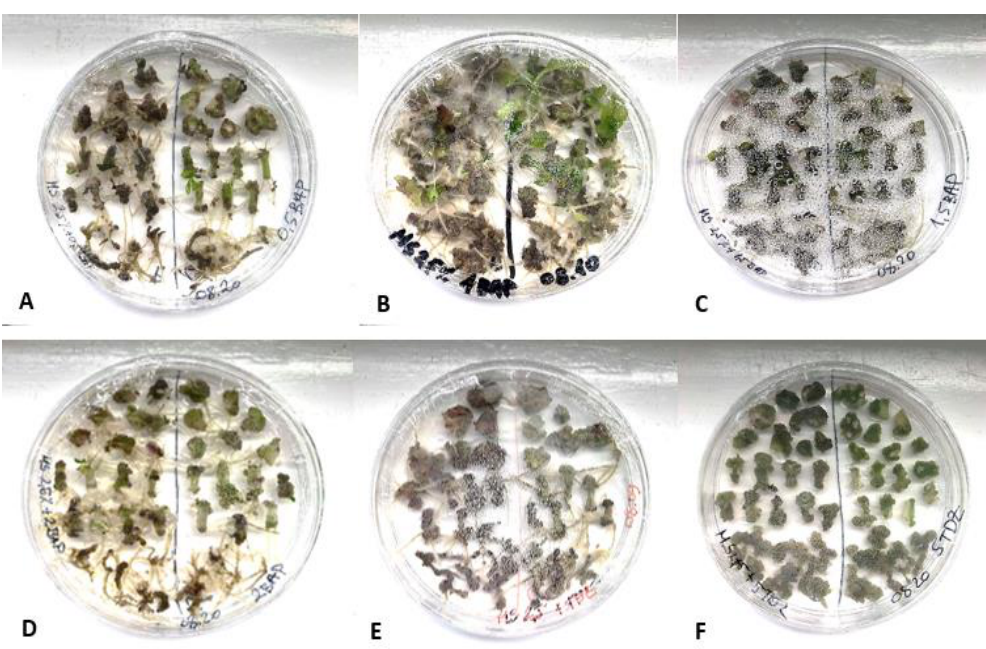
Figure 3. 4 weeks old explants on media containing different